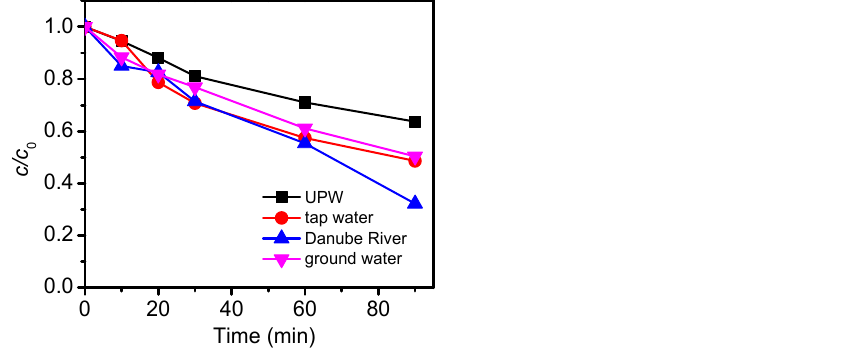
Figure 7. Efficiency of FB 1 (1.39 μ mol/dm 3 ) degradation in different types of water using UV irradiation at natural pH.